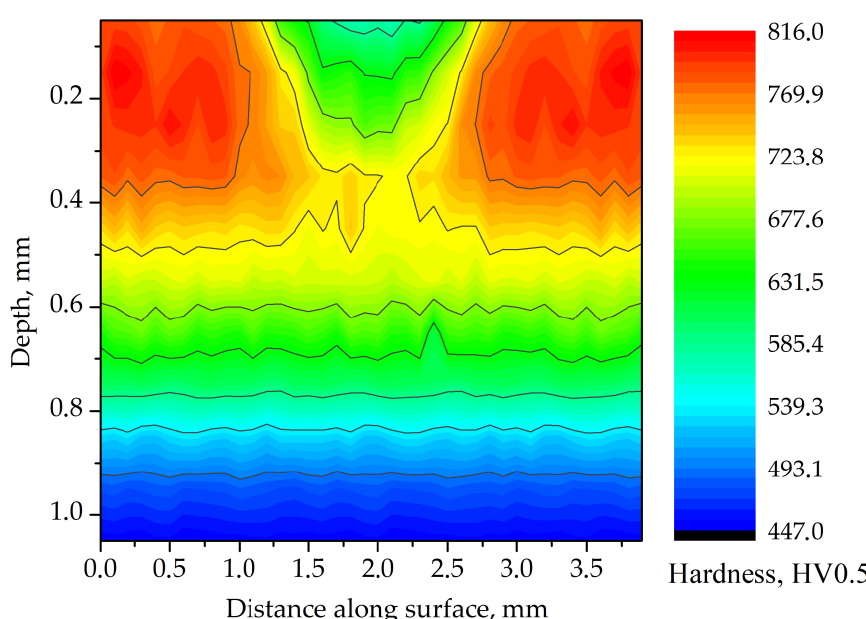
Figure 5. Microstructure of cross-section of tracks created by laser surface heating of the AISI 9310 carburized case-hardened steel: ( a , b ) track 1; ( c , d ) track 2; ( e , f ) track 3; compared to the carburized case ( g , h ) prior to the laser heating.